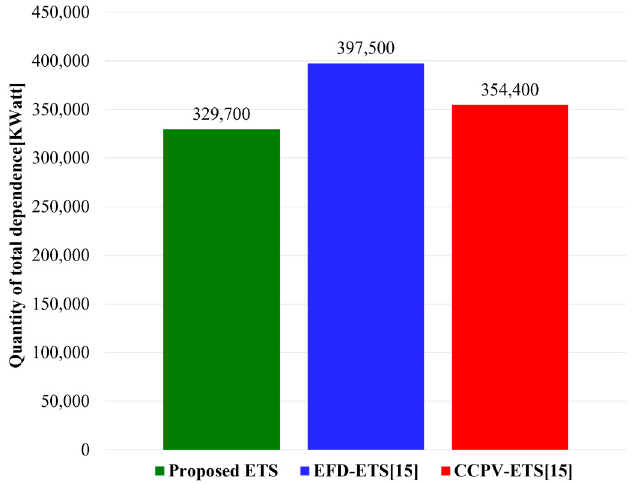
Figure 6. Quantity of total dependency of MGs on the main grid over a year by the proposed ETS, EFD-ETS, and CCPV-ETS.